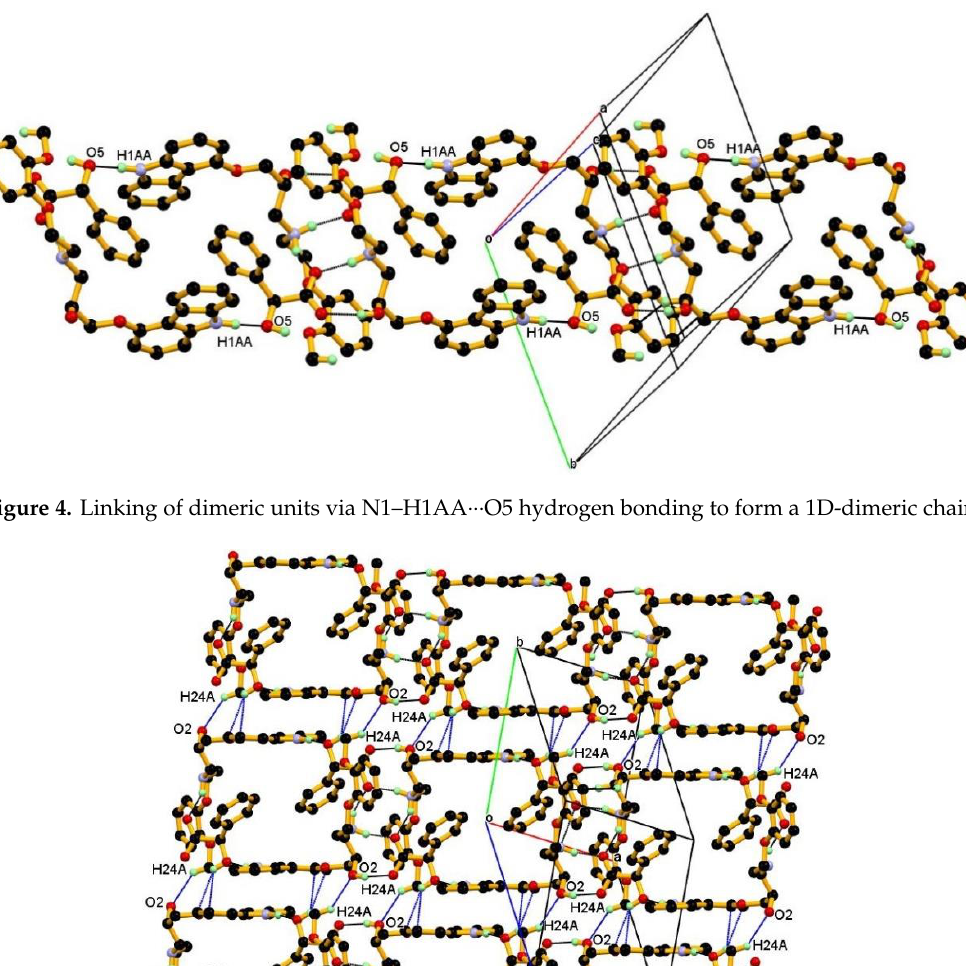
Figure 4. Linking of dimeric units via N1–H1AA···O5 hydrogen bonding to form a 1D-dimeric chain.